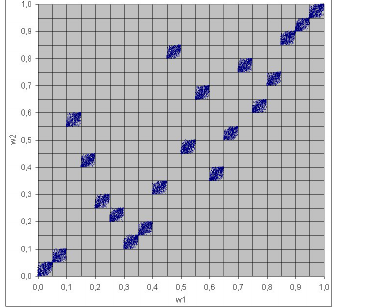
Figure 17: Normal copula driver, ρ = 0.6